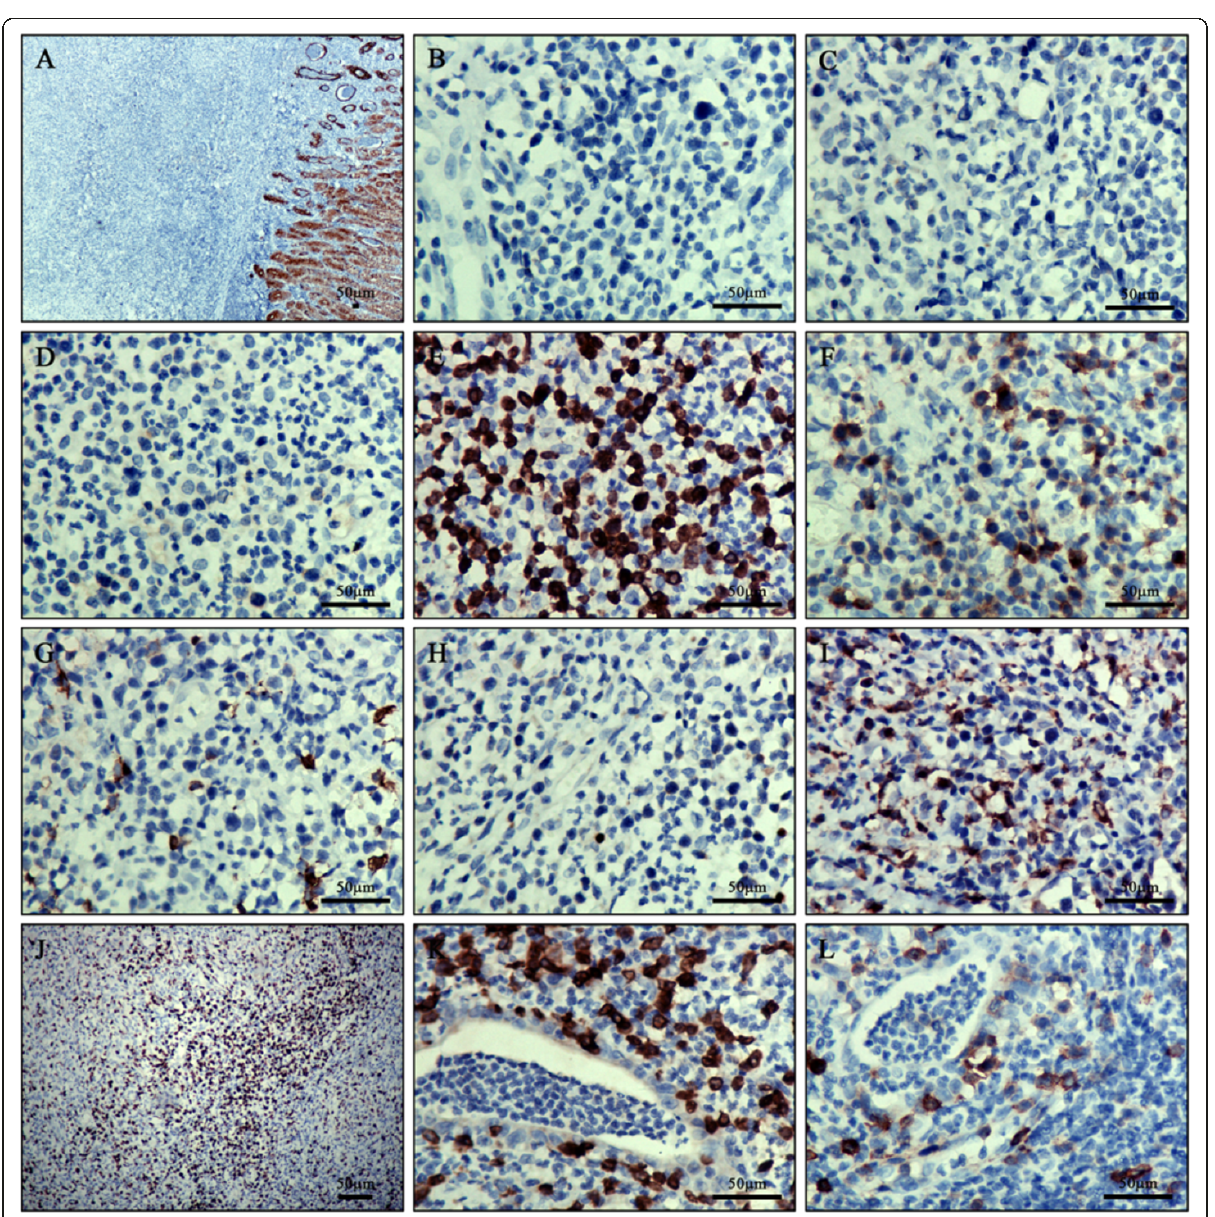
Figure 2 Immunohistochemical staining. A : The epithelium of gland was positive staining for AE1/AE3. B - D : The tumor cells were negative staining for CD5, CD8 and CD56. E : The tumor cells were strongly diffuse positive staining for CD3. F : The tumor cells partially expressed CD30. G and H : CD20 and Pax-5 labeled the scattered B cells amidst the inflammatory infiltrate. I : The histiocytes among the inflammatory infiltrate were positive for CD68. M and N : CD31 and CD34 underlined the rich vascular channels, whereas the histiocytoid cells were negative. J : Ki67 index was about 20%. K and L : The intraepithelial lymphocytes in the adjacent mucosa were positive for CD3 and